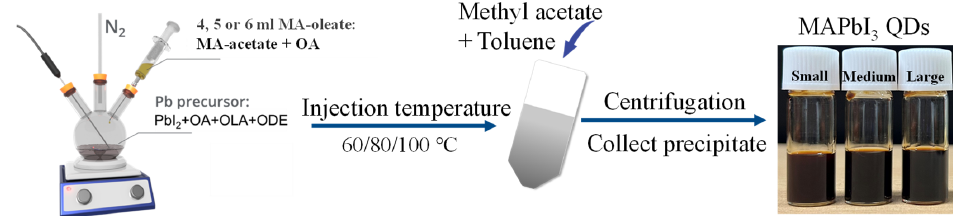
Figure 1. The schematic diagram of synthesizing MAPbI 3 quantum dots.